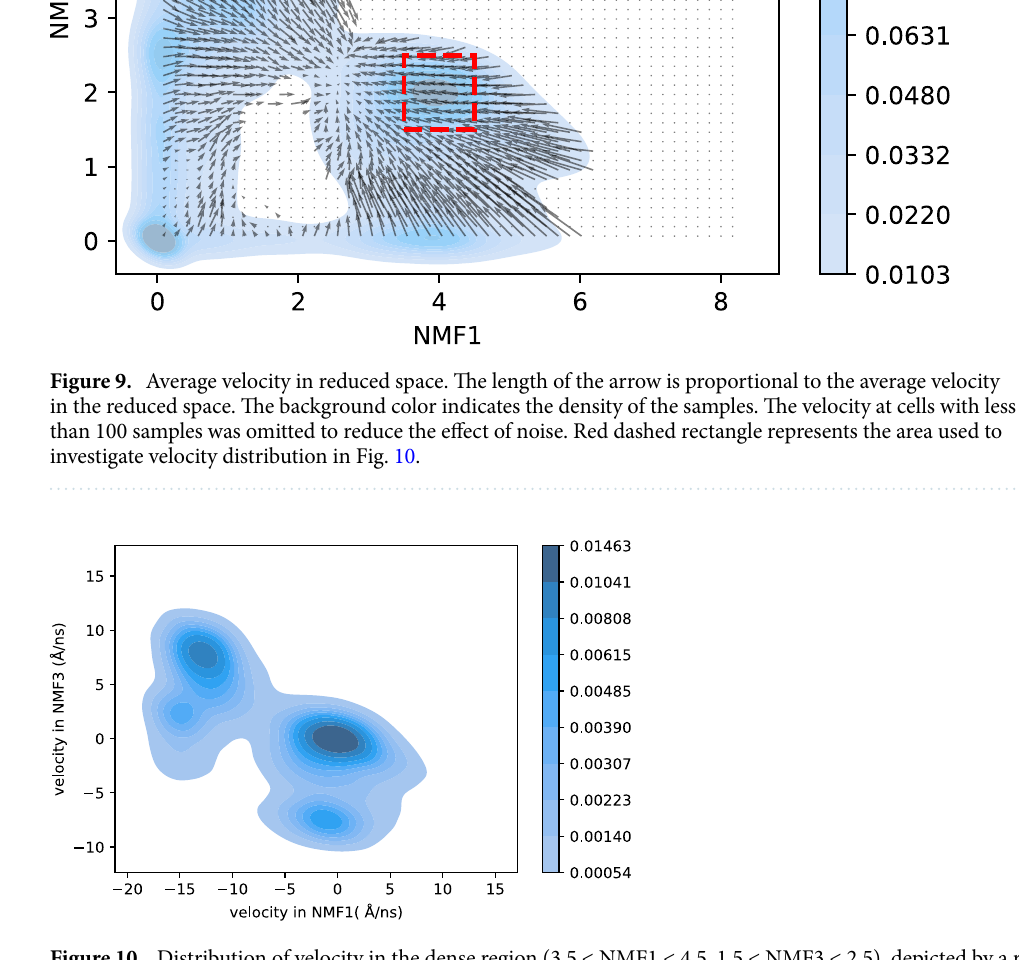
Figure 10. Distribution of velocity in the dense region (3.5 < NMF1 < 4.5, 1.5 < NMF3 < 2.5), depicted by a red dashed rectangle in Fig.